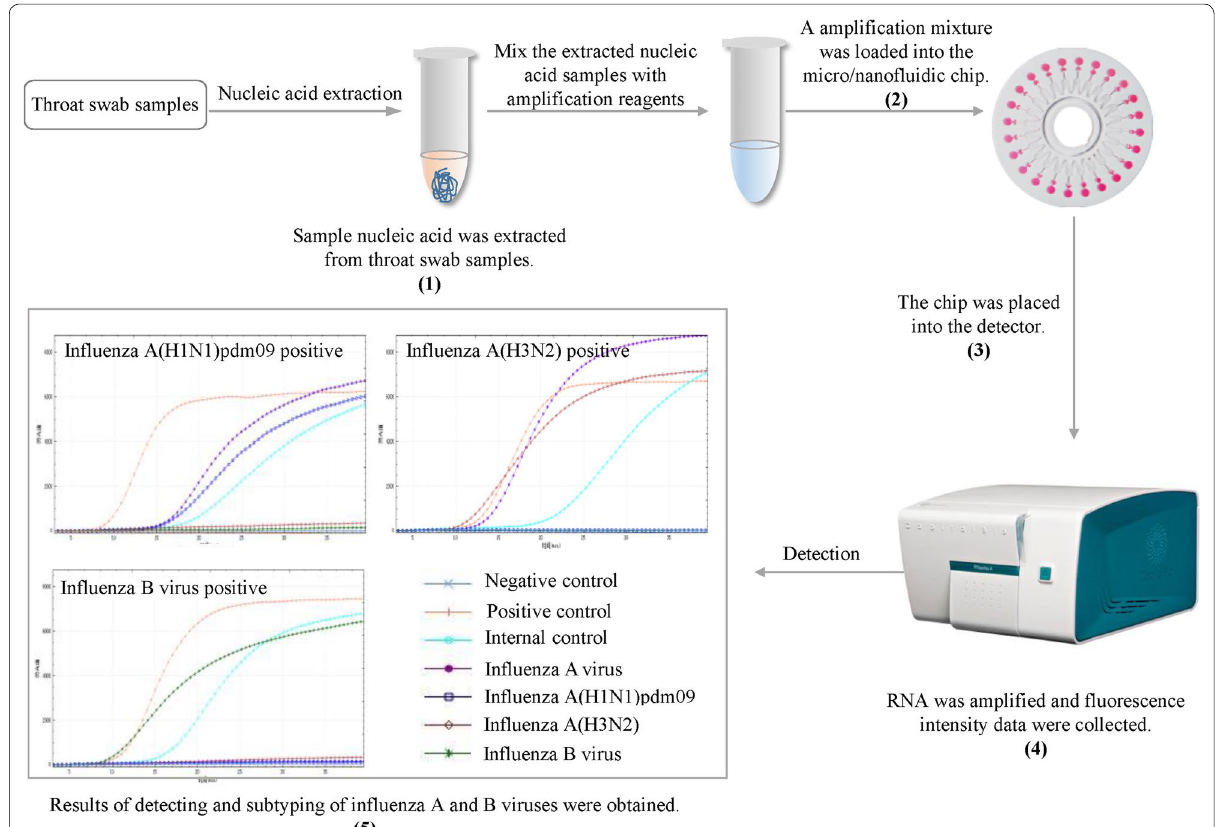
Fig. 3 The workflow of MNCP. The steps were as follows: (1) Nucleic acid was extracted from throat swab samples. (2) A mixture including nucleic acid, basic NASBA reaction reagents, primers, and molecular beacon probes was loaded into the micro/nanofluidic chip. (3) The loaded chip was placed into the RTisochip-A detector (CapitalBio, Beijing, China). (4) RNA was amplified based on the NASBA and the fluorescence intensity data were collected and analyzed using the software. (5) Results of detecting and subtyping of influenza A and B viruses were obtained. Fluorescent curves were plotted by detection time (X-axis) against fluorescent intensity (Y-axis) for influenza A(H1N1)pdm09, A(H3N2), and influenza B virus,